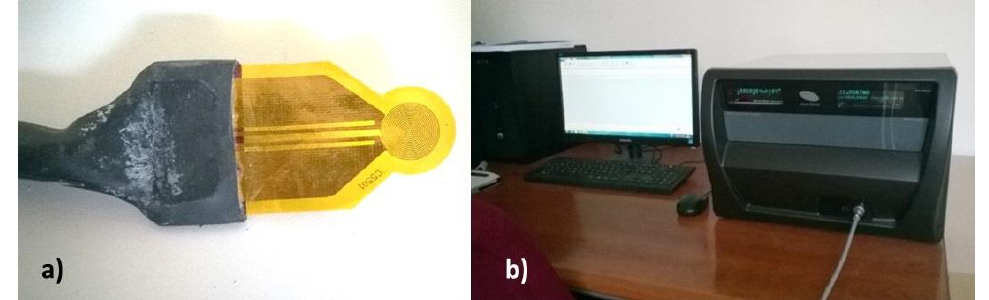
Figure 6. ( a ) Hot Disk sensor; and ( b ) Hot Disk facility.